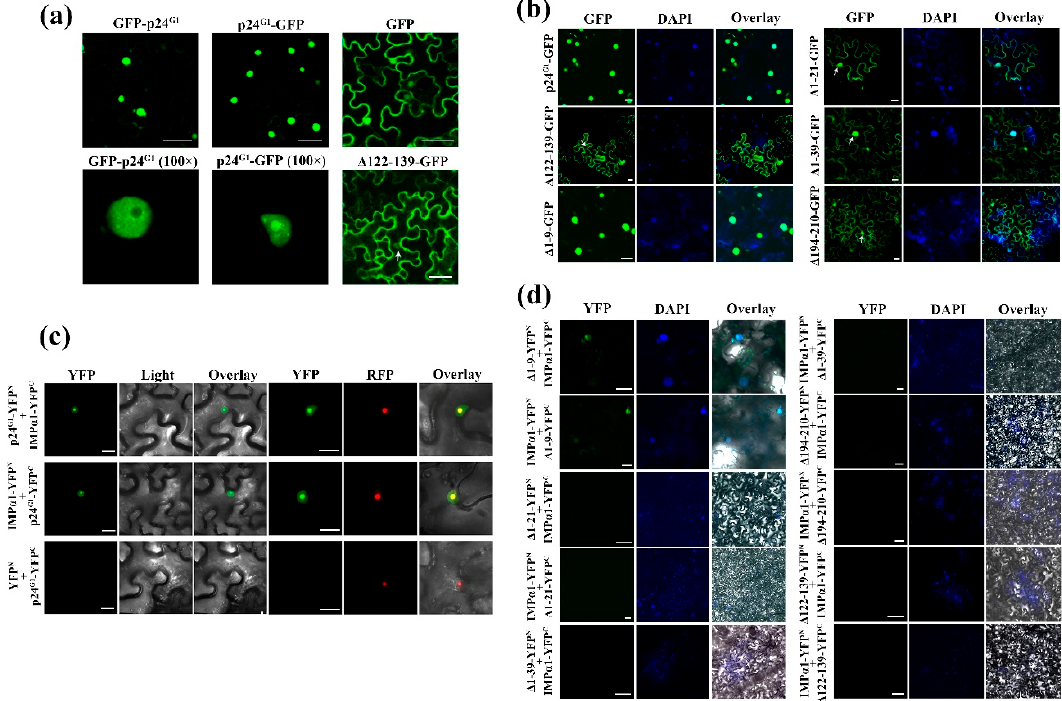
Figure 4. p24 of grapevine leafroll-associated virus 1 (p24 G1 ) is localized in the nucleus and interacts with importin α 1. ( a ) Confocal micrographs show the nuclear localization of fusion proteins p24 G1 –GFP and GFP–p24 G1 in epidermal cells of N. benthamiana leaves. Bars = 50 µ m. ( b ) Subcellular localization of p24 G1 mutants. Bars = 20 µ m. ( c ) p24 G1 interacts with N. benthamiana importin α 1 (NbIMP α 1) in the nucleolus. RFP-tagged fibrillarin of N. benthamiana was used as a nucleolar protein control. Bars = 20 µ m. ( d ) Analysis of the interaction between p24 G1 mutants and NbIMP α 1. Bars = 100 µ m (scale bars for the images marked with “ ∆ 1–9” are 20 µ m). Arrows indicate the nucleus ( a , b ). Nuclei of tobacco leaf epidermal cells were stained with DAPI ( b , d ).